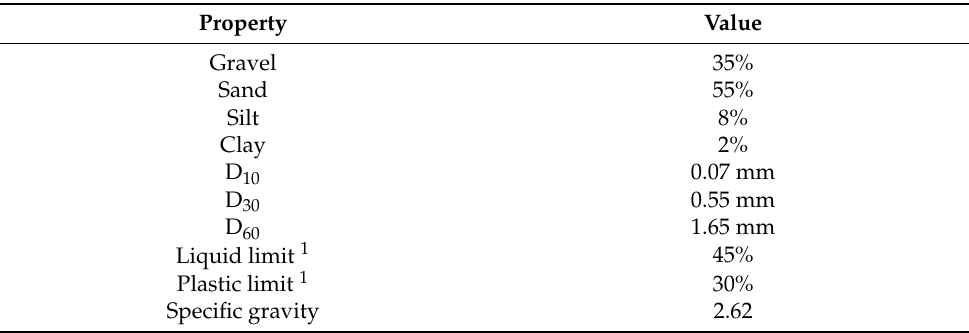
Figure 1. Particle size distribution of the residual soil. Table 1. Index properties of the residual soil.